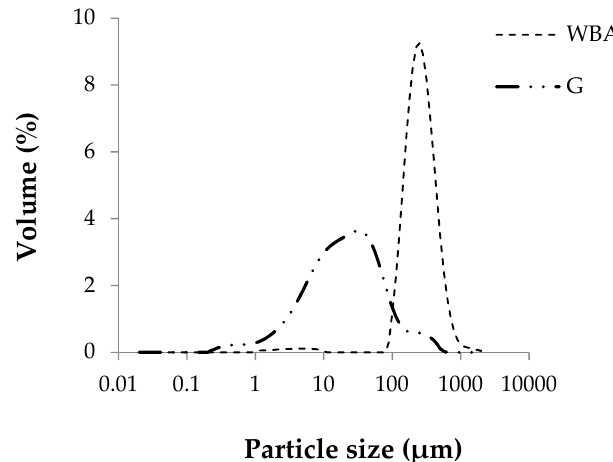
Figure 3. Particle size distribution of raw materials wood bottom ash (WBA) and GeoSilex (G). Table 3. Chemical composition of wood bottom ash (WBA) and GeoSilex (G) raw materials. The WBA X ‐ ray diffraction (XRD) pattern (Figure 4) shows that the main crystalline mineralogical phase of the residue is quartz. It also has lower intensity diffraction peaks corresponding to calcium carbonate (CaCO 3 ) and aluminum and iron silicates (AlKSi 3 O 8 ). The XRD pattern of the by ‐ product GeoSilex indicates that it is mainly constituted of portlandite (Ca(OH) 2 ), due to the easy carbonation of the by ‐ product, with small diffraction peaks corresponding to calcium carbonate.